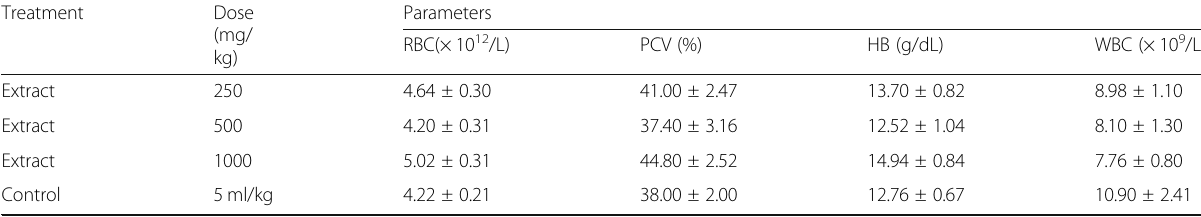
Table 4 Effects of ethanol fruit extract of H. madagascariensis on hematological parameters in wistar rats. (Mean ± S.E.M). There was no statistically significant ( P > 0.05) difference in the red blood cell count, packed cell volume, hemoglobin concentration and white blood cell count values of the extract treated groups when compared to the control. However, there was a marginal decrease in the white blood cell count of the treated groups compared to the control